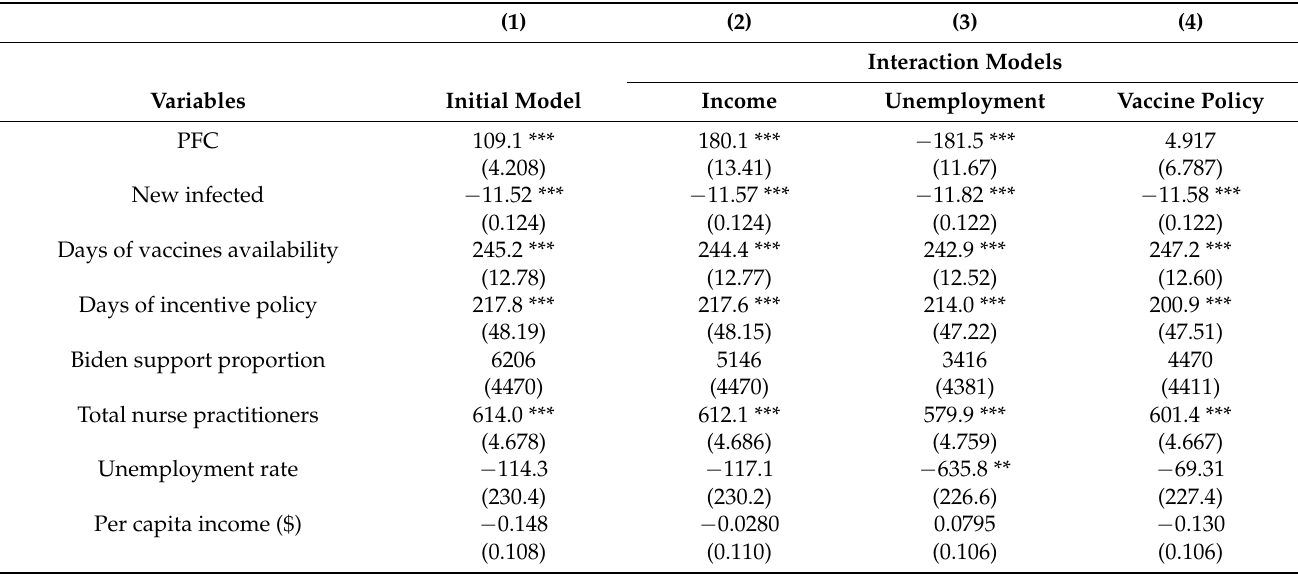
Table 2. Time series analysis of public emotion and